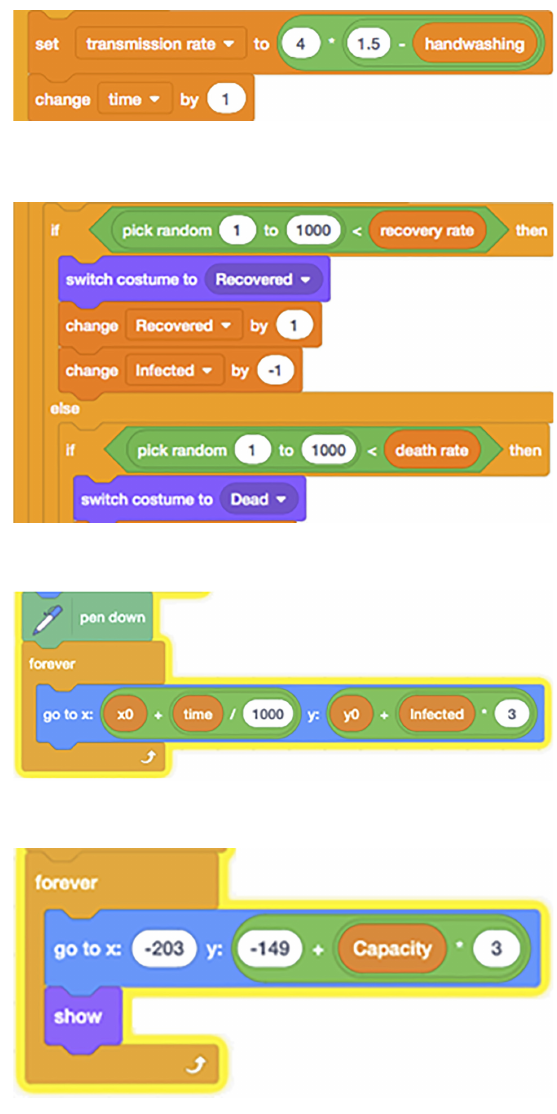
Figure 15. Coding blocks for illustrating the transmission equation in simulation